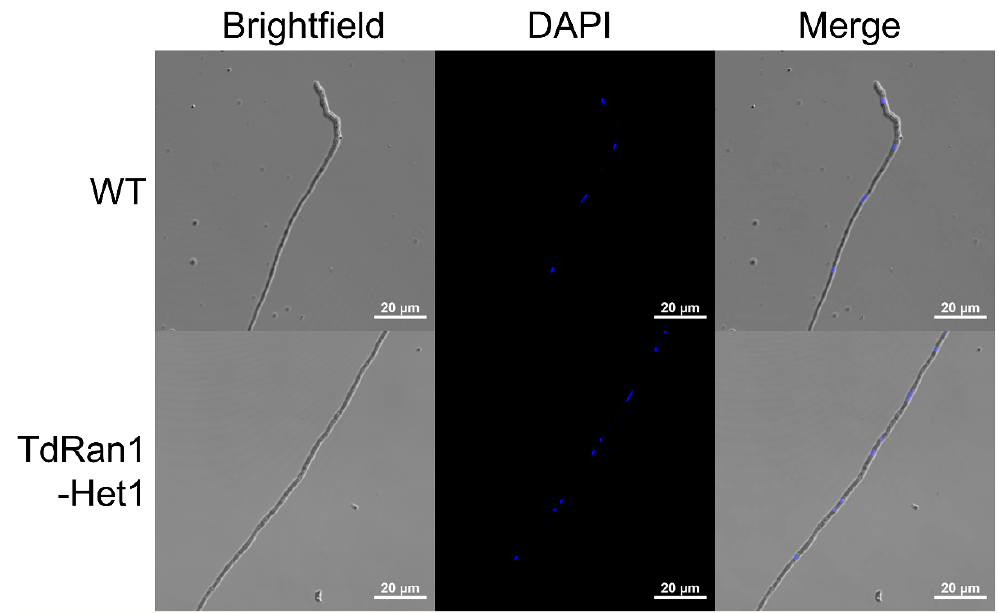
Figure 5. DAPI-stained nuclei of wild-type and the CpRan1 -null mutant mycelia. Brightfield: Light microscopic images of mycelia. DAPI: DAPI-stained images of corresponding brightfield mycelia. Merge: Merged images are shown. Strains are indicated on the left. WT and TdRan1-Het1 indicate wild-type EP155/2 and heterokaryotic CpRan1 -null mutant strain, respectively.